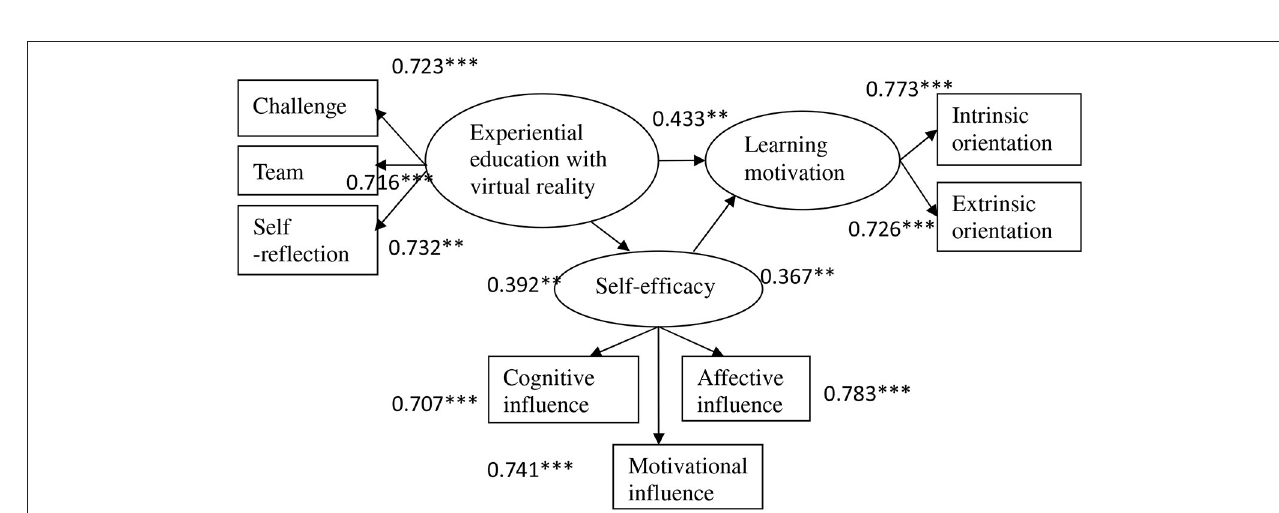
FIGURE 1 | The path coefficients analysis. ** p < 0.01 and *** p < 0.001.